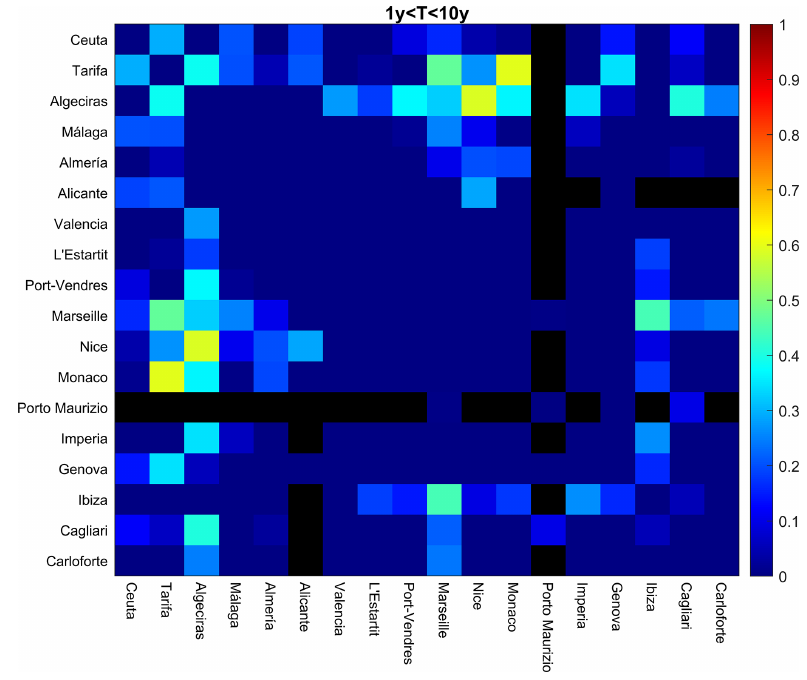
Figure A1. Differences between the correlation of tide gauge series and the correlation between SOCIB model series (with random noise added) at the points closest to each tide gauge for the frequency band 1 y<T < 10 y .